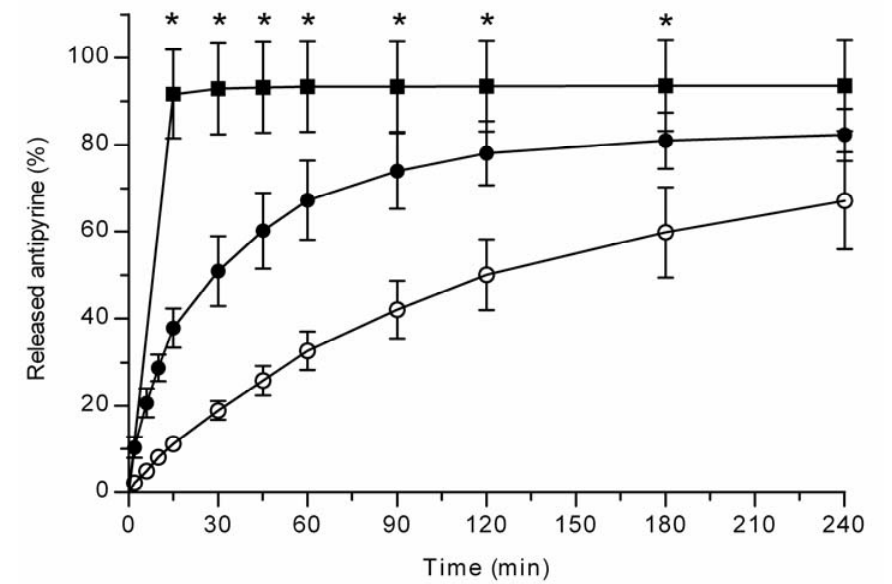
Figure 2. Antipyrine release (%) from TCPSi microparticles at pH 7.4 PBS (+37°C) with centrifuge ( ■ ) and well-plate methods (polyester ( ○ ) and polycarbonate ( ● ) membranes). Mean ± SD values are shown (n = 3). Statistical differences: * p < 0.05 centrifuge vs . well-plate (polyester membrane).